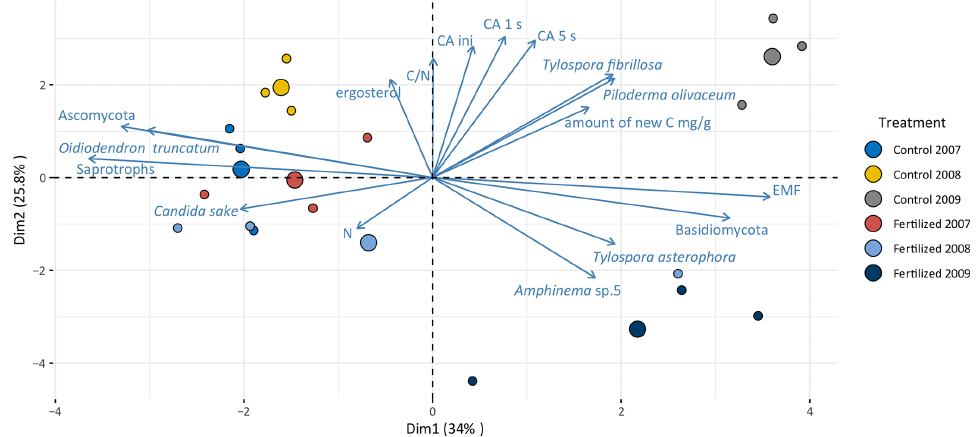
Figure 4. Principal component analysis of the most abundant fungal species and the properties of the organic material inside the mesh bags.